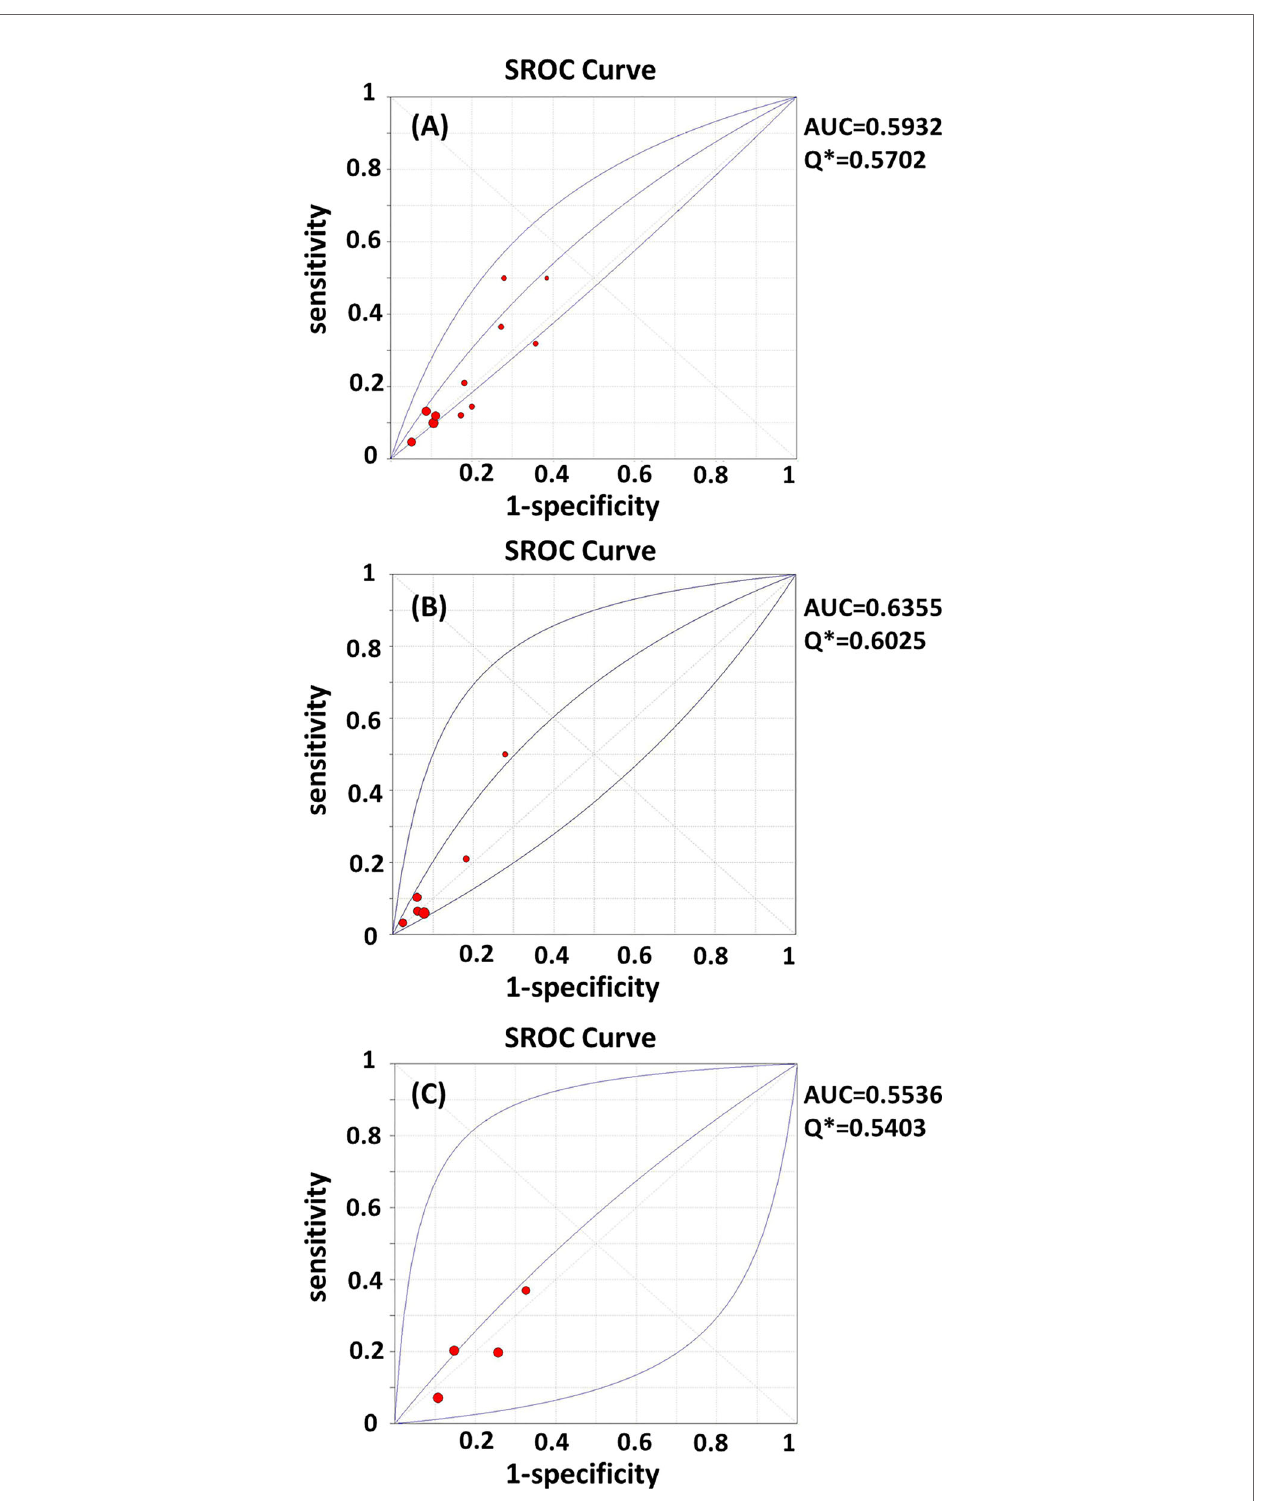
FIGURE 2 | (A – C) SROC curves of AMH in the prediction of spontaneous clinical in (A) all women; (B) women younger than 35 years; (C) women elder than 35 years. AUC, area under the summary receiver operating characteristic curve; Q*,Cochran ’ s Q index.